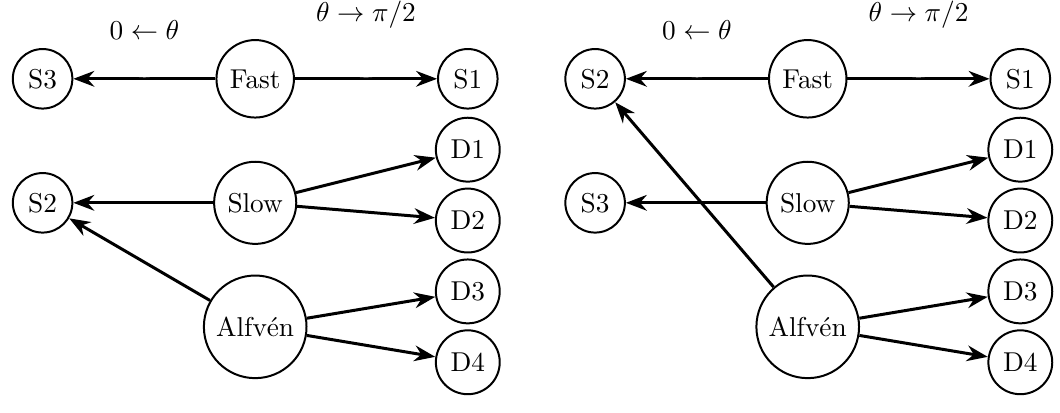
Figure 4 . Diagrams depicting the (cid:18) -dependent pattern of transmutation from sound to di(cid:11)usive modes for Alfv(cid:19)en waves and slow and fast magnetosonic waves. The left and right diagrams corre- spond to weak- and strong-(cid:12)eld regimes. The relevant dispersion relation are stated in eqs. (4.14) and